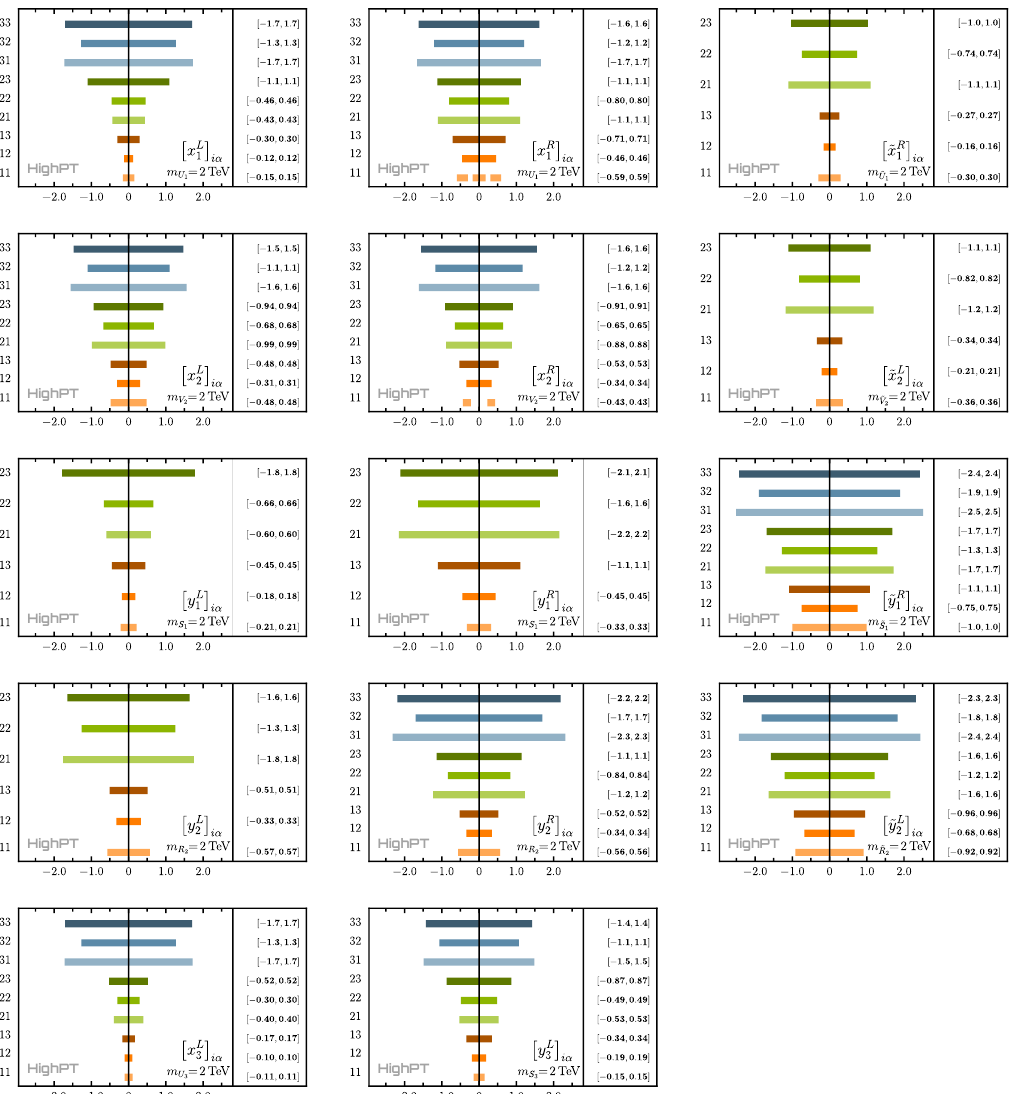
Figure 10. LHC constraints at 95 % CL on the coupling constants of all leptoquarks, where a single coupling is turned on at a time. The masses of all leptoquarks are fixed to 2 TeV. The numbers on the left-hand side of each plot correspond to the respective quark and lepton flavor indices iα . See table 2 for the definition of the couplings. All constraints are compatible with the SM except for the bound on [ x R ] for which we find a ∼ 2 σ 11 2